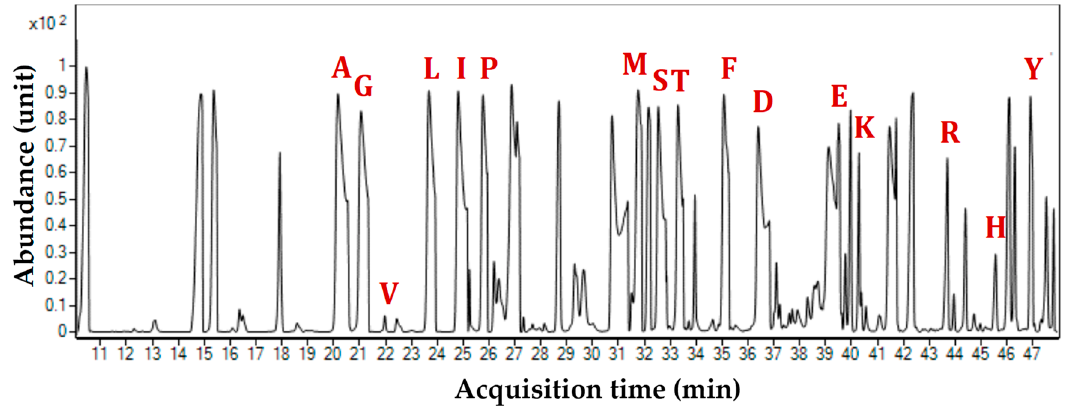
Figure 3. Representative total ion chromatogram (TIC) of GC-MS showing the presence of 16 amino acids from the protein hydrolysates of Xanthomonas oryzae pv. oryzae BXO43 when fed with xylose and glucose. Each peak is marked in a single letter code corresponding to the time of elution for a particular amino acid, as follows: A-Alanine; G-Glycine; V-Valine; L-Leucine; I-Isoleucine; P-Proline; M-Methionine; S-Serine; T-Threonine; P-Phenylalanine; A-Aspartate; G-Glutamate; L-Lysine; A-Arginine; H-Histidine; and T-Tyrosine. Owing to the gram-negative nature of Xanthomonas , additional peaks in the chromatogram are considered to be the cell wall components, obtained when performing the acid hydrolysis of the harvested Xoo samples.